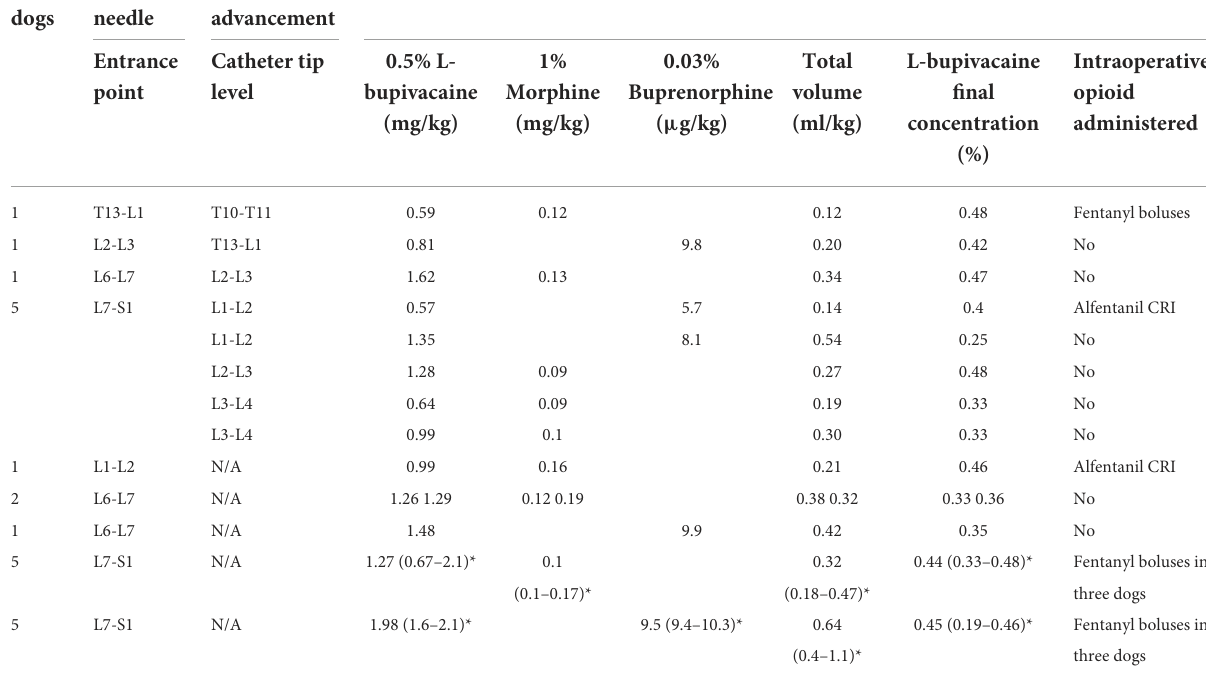
TABLE 3 Details regarding preoperative extradural and extradural catheter placement, drugs used and intraoperative opioid requirement in a cohort of dogs undergoing cholecystectomy. N of Tuohy dogs